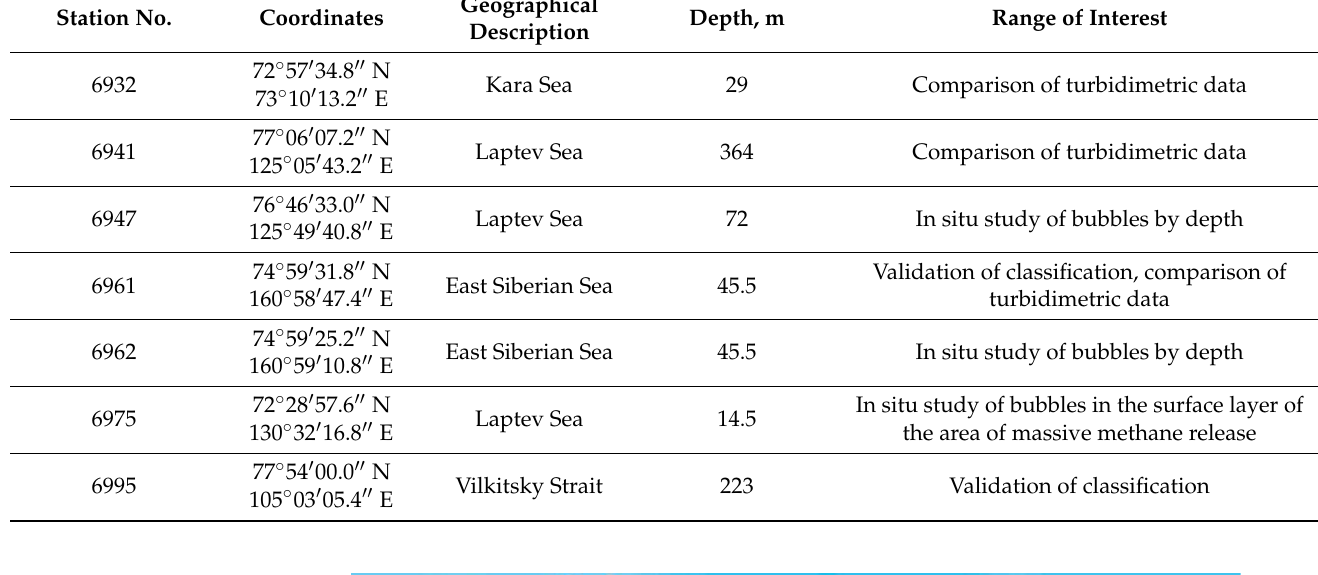
Table 3. Description of the AMK-82 stations.